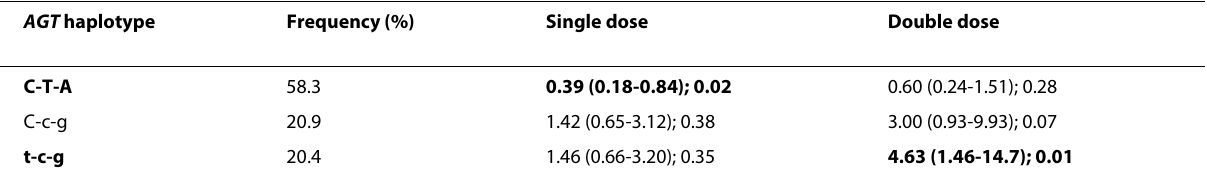
Table 2: Relative risk estimates for REN (A) and AGT (B) haplotypes A: Relative risk estimates (95% CI; p-value) for maternal AGT haplotypes (n = 87 family triads)